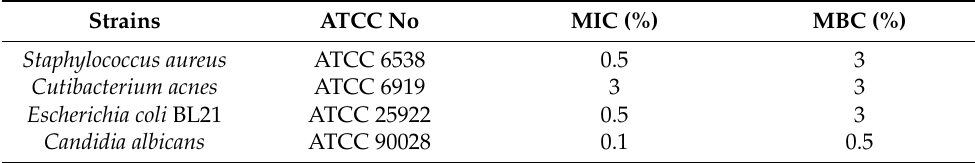
Table 1. Antimicrobial activity of OSO.